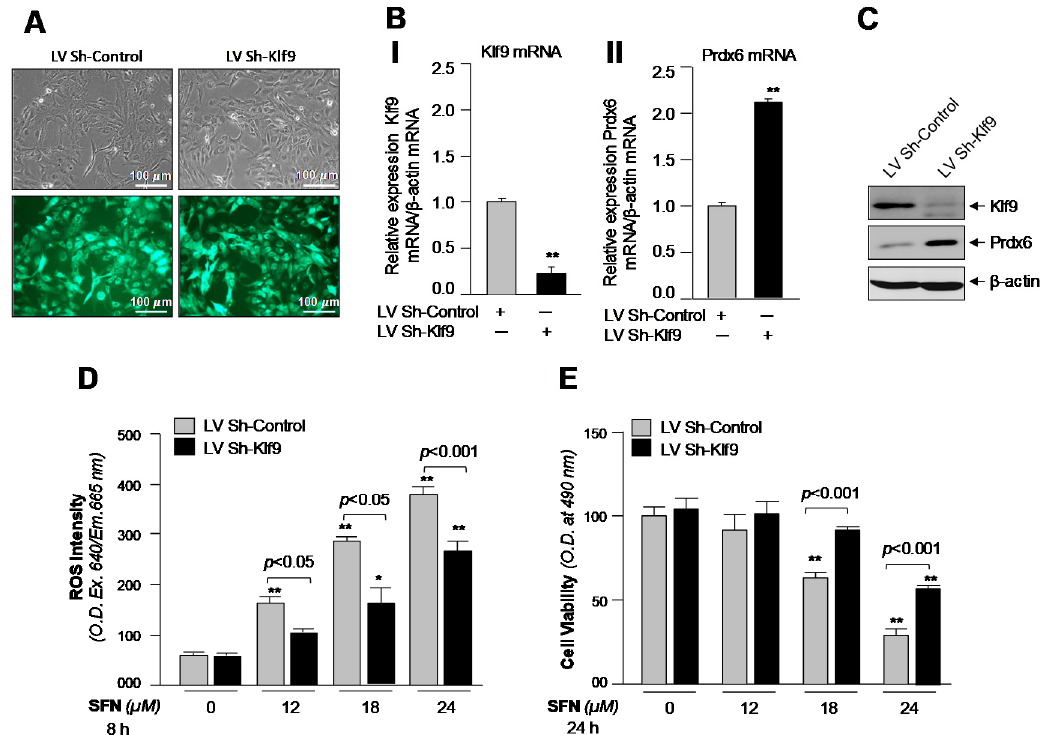
Figure 8. Klf9-deficient hLECs displayed increased Prdx6 expression with reduced ROS level and conferred resistance against toxic doses of SFN. ( A – C ) Klf9- knockdown with its ShRNA showed enhanced Prdx6 expression. hLECs were stably infected either with GFP (green fluorescent protein) linked lentiviral (LV) Sh-Control or GFP linked LV Sh-Klf9 linked as described in Materials and Methods. ( A ) Photomicrograph representing stably infected hLECs, left panel: LV Sh-Control; right Panel: LV Sh-Klf9. ( B ) Total RNA was isolated from infected hLECs and RT-qPCR analysis was conducted with primers specific to Klf9 and Prdx6. Data represent the mean ± S.D. of three independent experiments. ** p < 0.001; LV Sh-Klf9 versus LV Sh-Control. ( C ) Cellular extract prepared from infected hLECs having equal amounts of protein was immunoblotted with antibody specific to Klf9 or Prdx6 or β -actin. ( D and E ) Depletion of Klf9 suppressed ROS levels and increased the cell viability. hLECs were stably infected with LV Sh-Control or LV Sh-Klf9 lentiviral particle following section pressure as described in Materials and Methods. Cells were harvested in 96 well plate. After24 h, those cells were exposed to DMSO (0), 12, 18 and 24 µ M of SFN. 8 h of SFN exposure ROS intensity ( D ) and at 24 h cell viability ( E ) were examined. * p < 0.05, ** p < 0.001; SFN treated versus control, p < 0.05, p < 0.001; LV Sh-Klf9 versus LV Sh-Control.